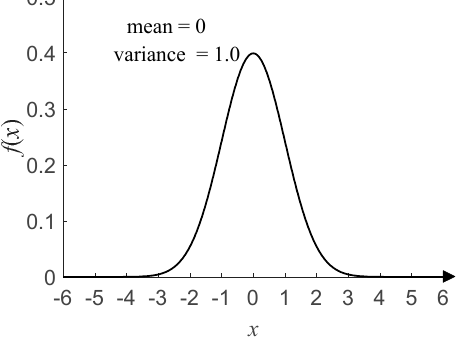
Figure 2. PDF of Gaussian distribution.